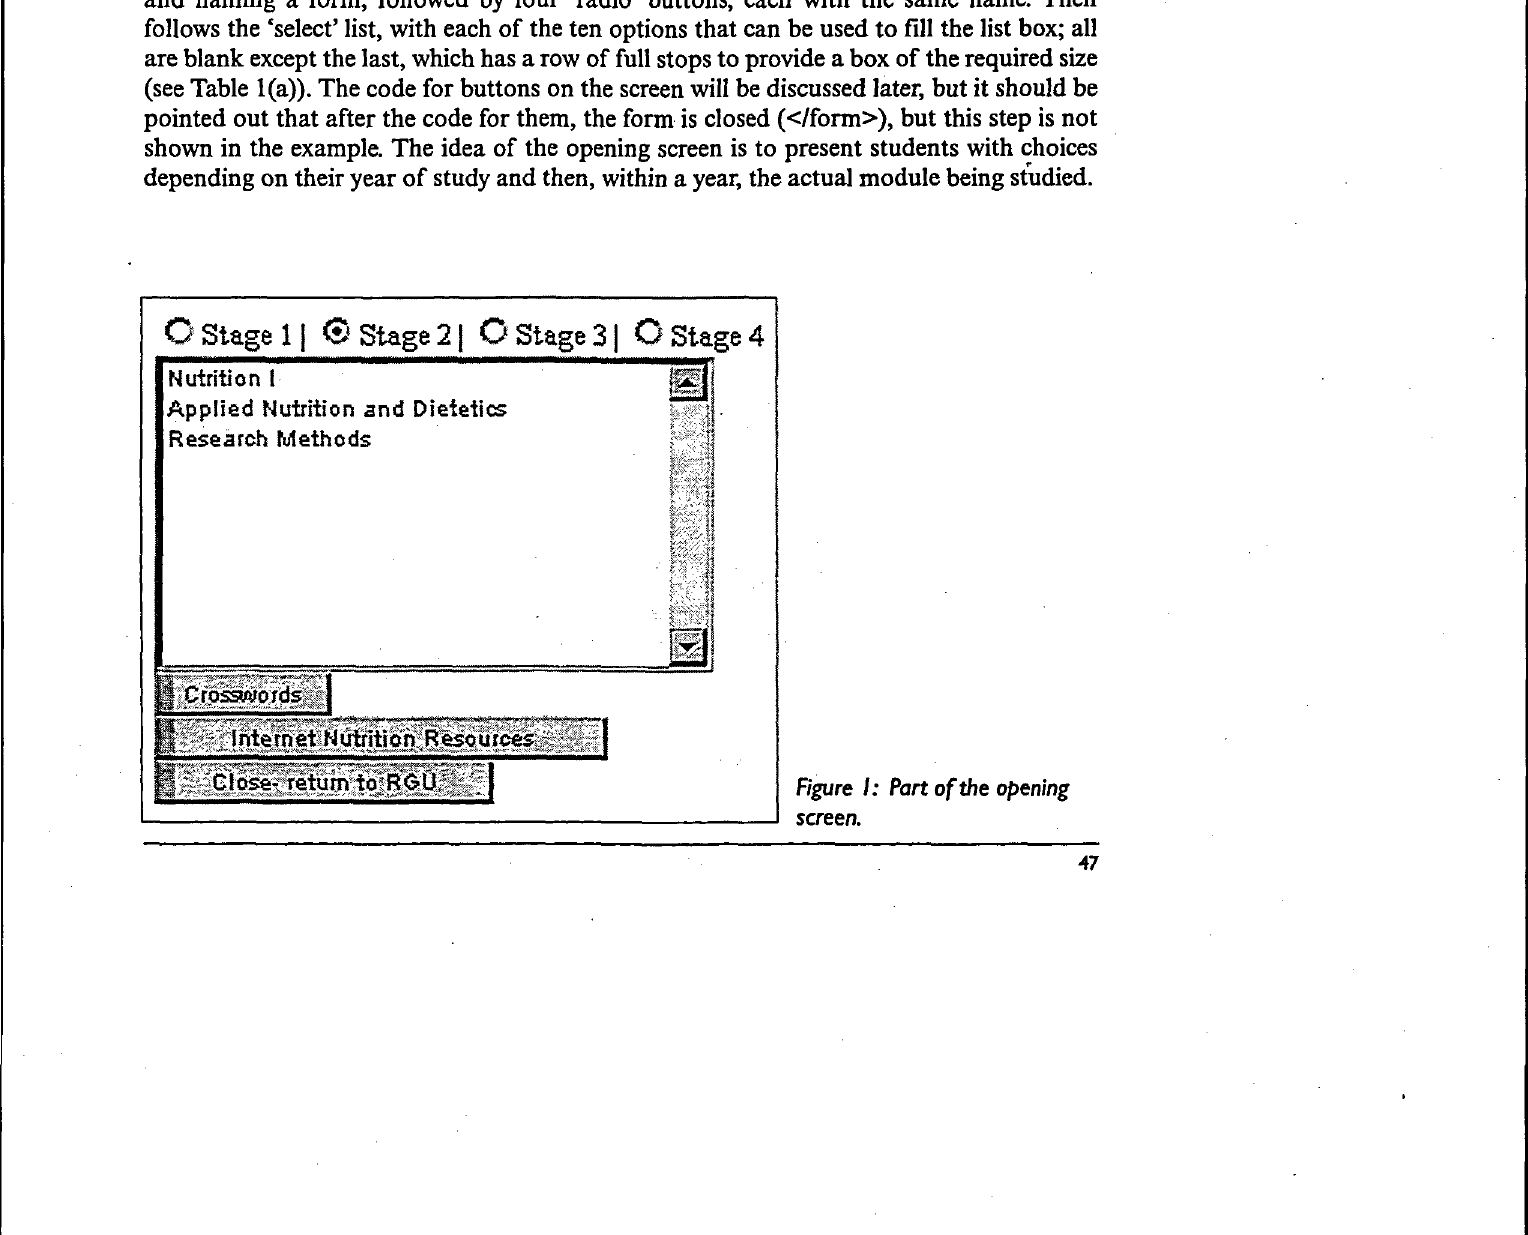
Figure I: Part of the opening